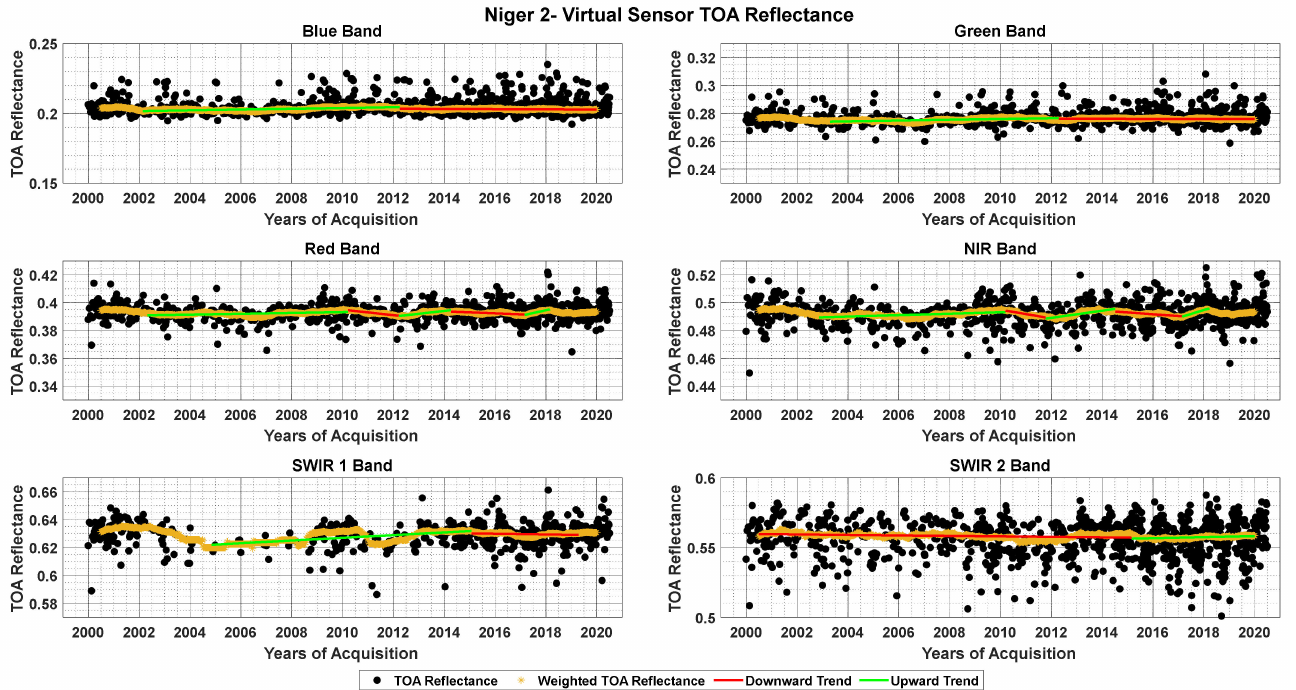
Figure 11. TOA reflectance data of the virtual constellation over Niger 2 for blue, green, red, NIR, SWIR 1, and SWIR 2 bands with fitted trend lines before and after turning points. Table 12. Change point detection by sequential version of the Mann–Kendall test for Niger 2.